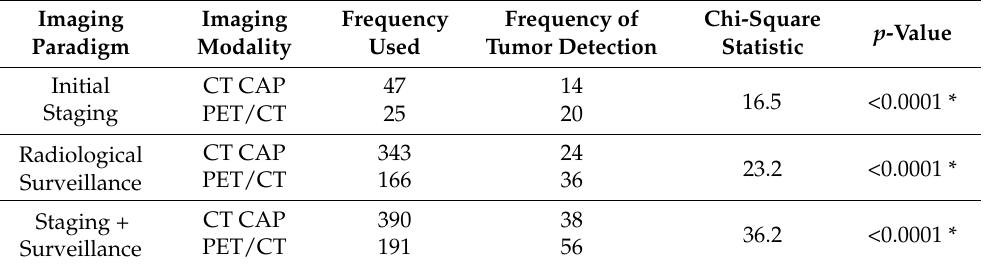
Table 5. Univariate Analysis of Frequency of Tumor Detection by Radiological Modality. * indicate significant results, p -value <